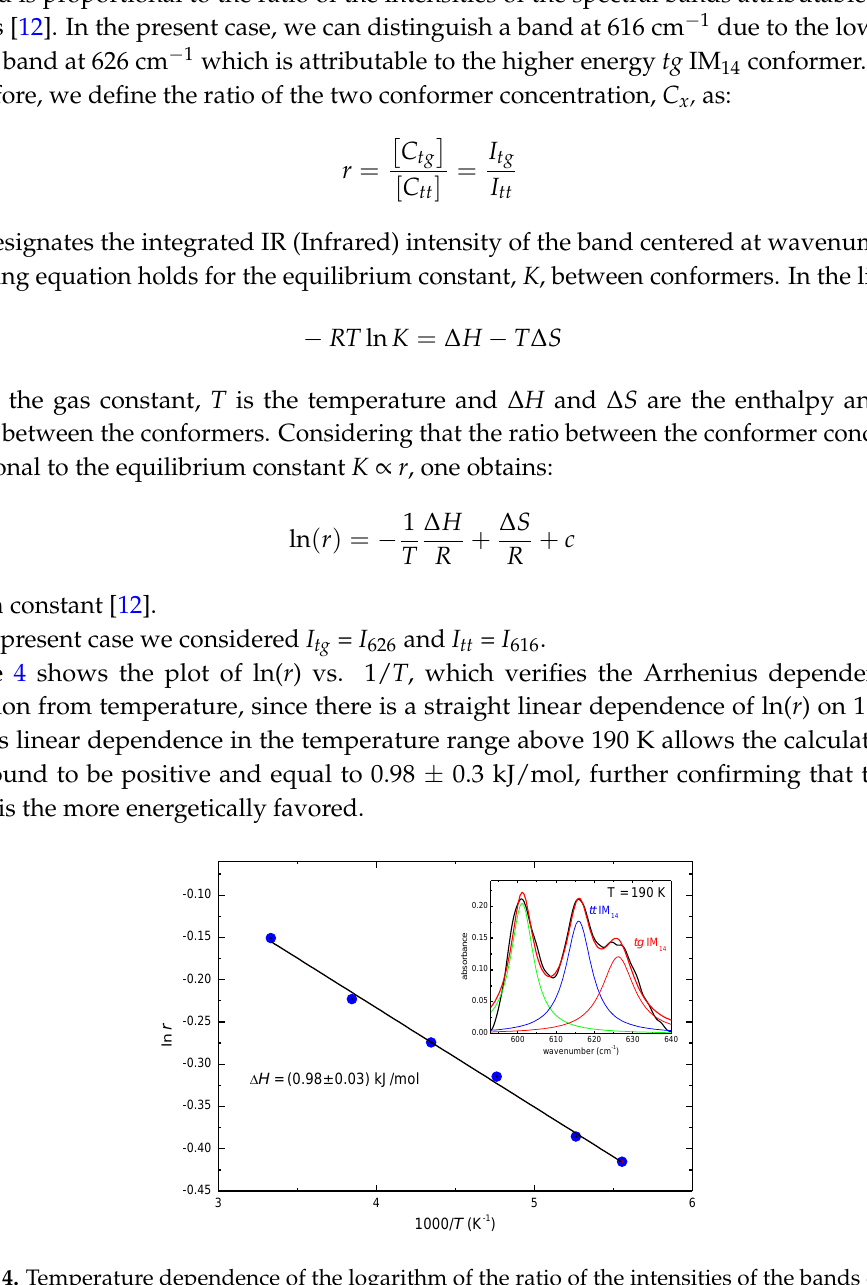
Figure 4. Temperature dependence of the logarithm of the ratio of the intensities of the bands due to the two IM 14 conformers and best fit line. In the inset an example of the fit of the absorbance spectrum and deconvolution into the contributions of the conformers is reported.